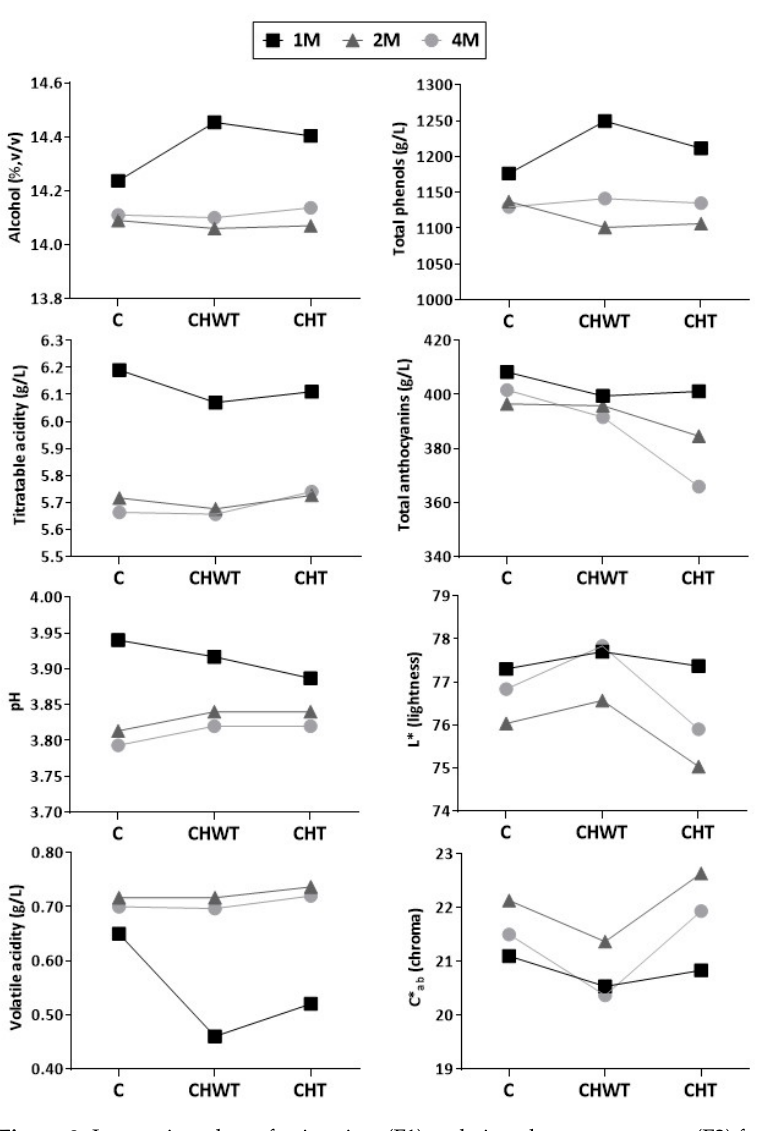
Figure 3. Interaction plots of aging time (F1) and vine-shoots treatments (F2) for analytical parameters in Malbec wines by two-way ANOVA. C, control; CHWT, untoasted vine-shoot chips; CHT, toasted vine-shoot chips; 1M, 30 days; 2M, 60 days; 4M, 120 days.